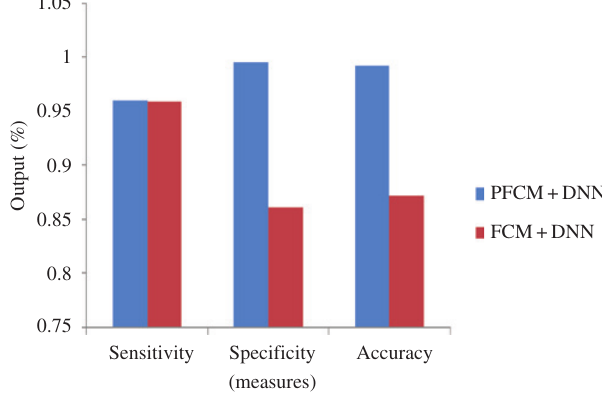
Figure 8: Performance of Segmentation Phase Using Different Measures.